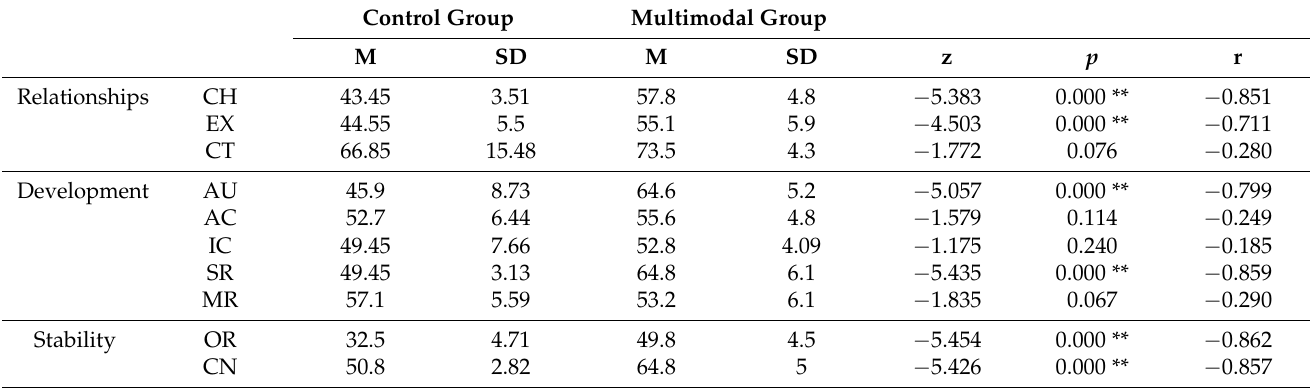
Table 11. Comparison between control and multimodal groups in the post-test. Family climate.